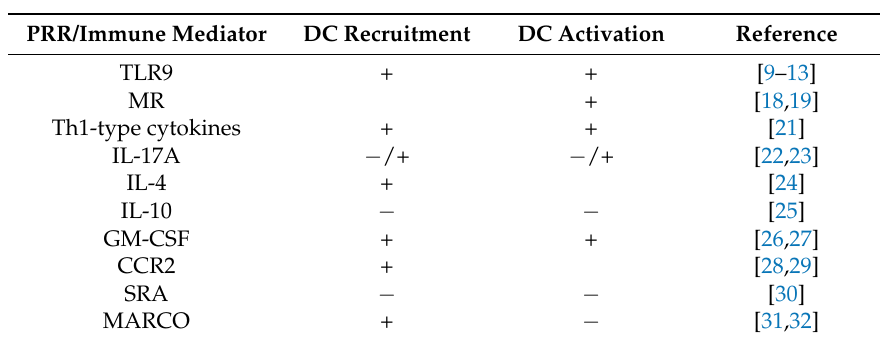
Table 1. Pattern recognition receptors (PRR)/Immune mediator effects on dendritic cell (DC) recruitment and